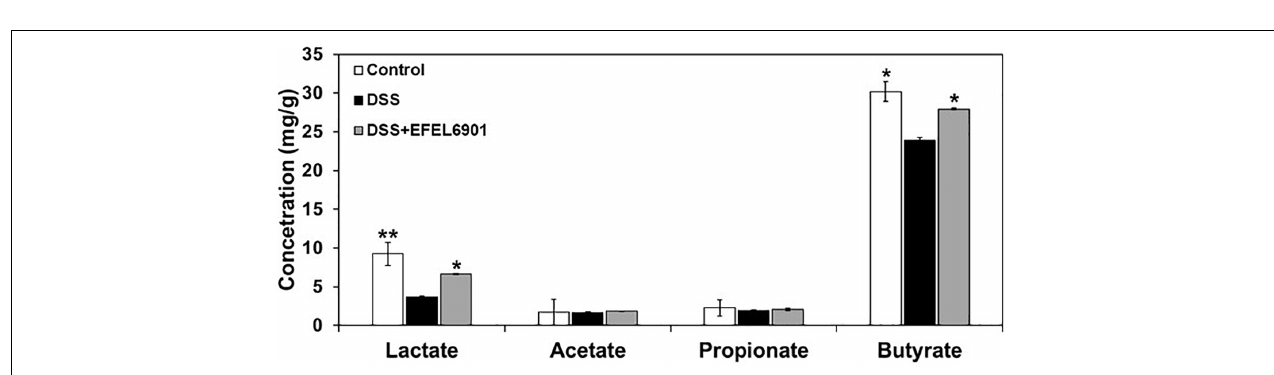
FIGURE 7 | Bacterial taxonomic compositions in DSS-induced colitis mice after oral administration of Limosilactobacillus reuteri EFEL6901. (A) The differences heatmap of microbial abundance at genus level. (B) Biplot of the principal components analysis (PCA) of microbial abundance at genus level. (C) Relative abundance of Firmicutes and Bacteroidetes at the phylum level. (D) Relative abundance of Lactobacillus at the genus levels. (E) Relative abundance of Lachnospiraceae NK4A136 at the genus levels. Significant differences are presented with the DSS group: * p < 0.05; ** p < 0.01.